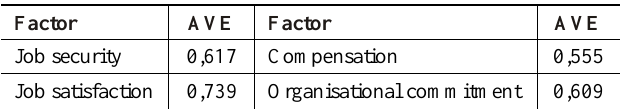
Table 3: AVE estimates for all factors